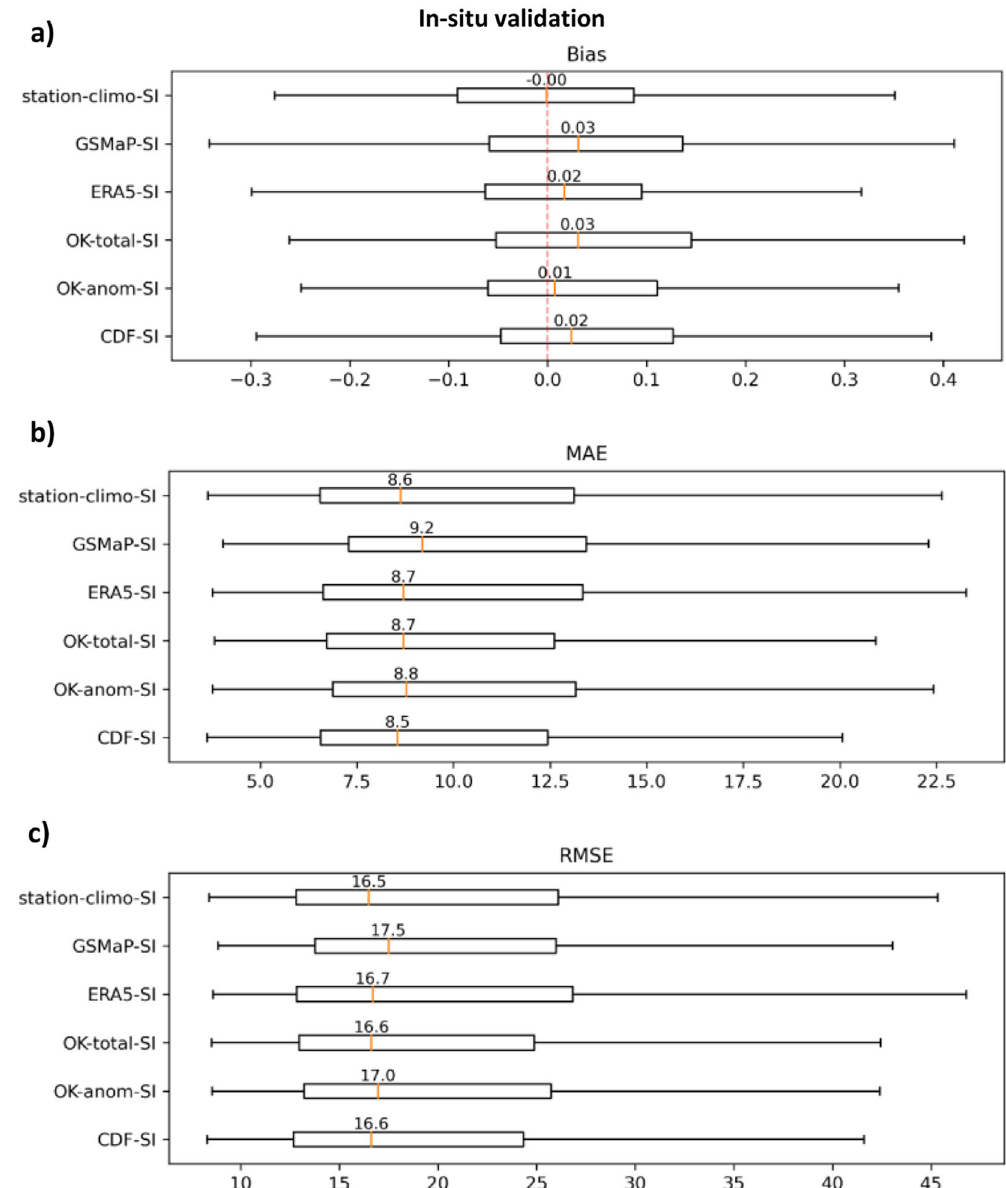
Figure 2. Boxplots of ( a ) bias, ( b ) root-mean-squared error (RMSE) and ( c ) mean absolute error (MAE) from in-situ cross-validation. Units are in mm/month. A value of zero is ideal for all three metrics. The boxes indicate the interquartile range (IQR), the whiskers extend out to the non-outlier minimum and maximums (Q1 − 1.5 × IQR and Q3 + 1.5 × IQR), and the line within the box represents the